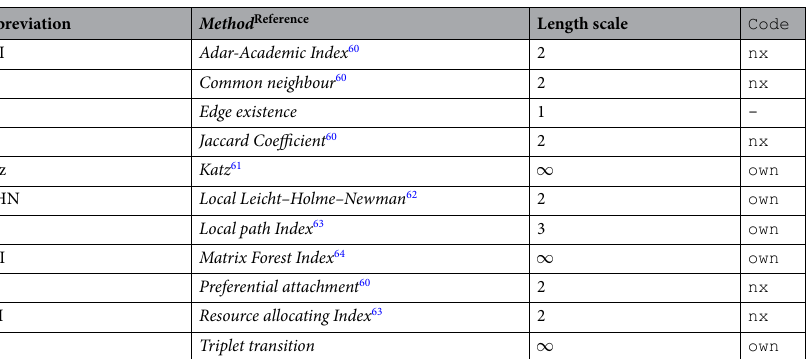
Table 2. Table of the link prediction methods used and their abbreviations. The length scale given indicates the longest path length involved in the method or equivalently the largest power of the adjacent matrix involved in the method. Under code , nx indicates that a NetworkX 65 library routine was used, while own indicates the authors’ own code was used. The Edge Existence (EE) approach was not investigated numerically but was included for the sake of comparison. All these methods, except for the Triplet Transition method, have a temporal path length of 0. That is they are derived solely from the current snapshot, G ( s ) , when making a prediction for links in the next snapshot G ( s + 1 ) . The Triplet Transition method has a temporal path length of 1 as it uses G ( s ) and G ( s − 1 ) to predict G ( s + 1 ) .